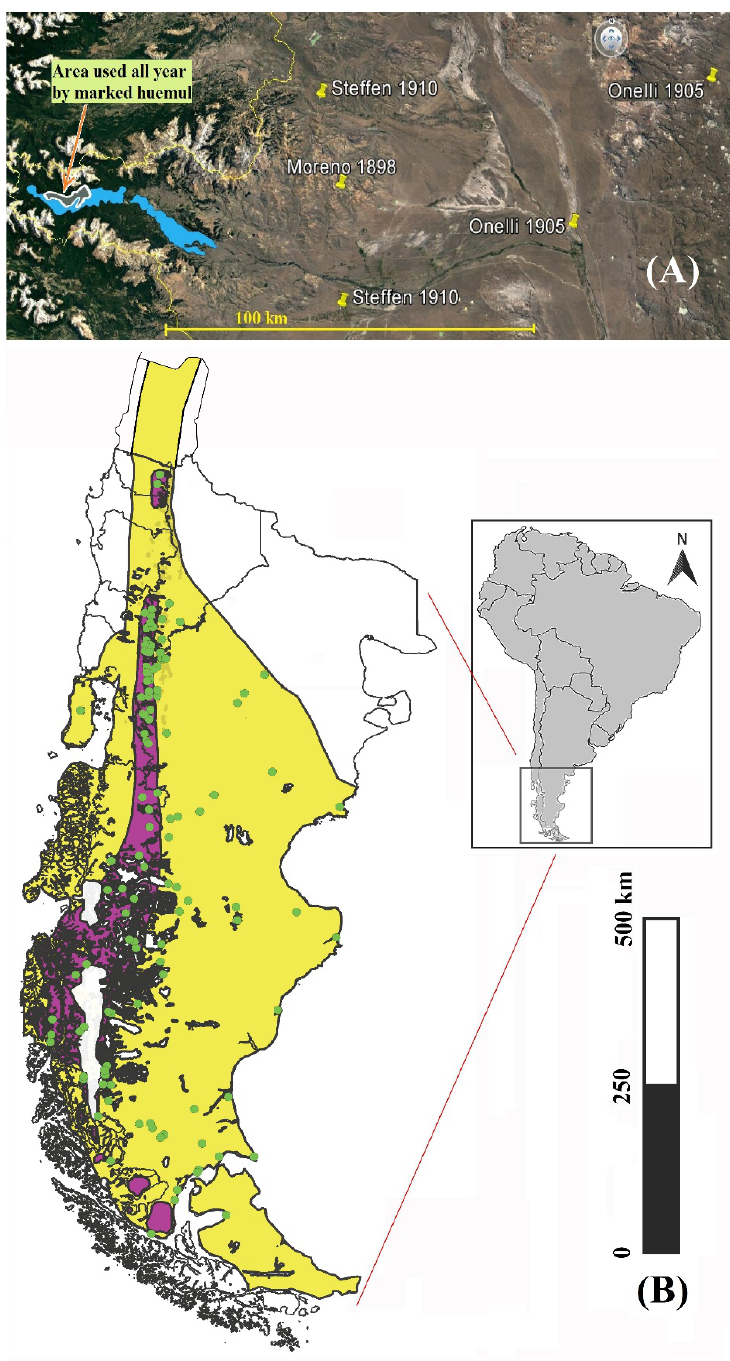
Figure 4. (A ) Historical and current spatial distribution of huemul in the Protected Park Shoonem. The blue polygons show lakes Fontana and La Plata. The current year-round range (grey polygon outlined in white) is at the upper elevational margin of summer ranges and near the Andean continental divide, compared to historically used areas (indicated by yellow tacks) [47,69,70]. Distances traveled to summer ranges in the past are well within common seasonal movement distances for similar cervids like Odocoileus . ( B ) Historical distribution (yellow); current distribution (purple: Jimenez et al. [71]), unsuitable areas (internal white zones indicating bare ice fields, rocky slopes without vegetation, or lakes), and historical locations (green dots), based on reports by naturalists, shed antlers, and archeological samples (Supplementary File S1).